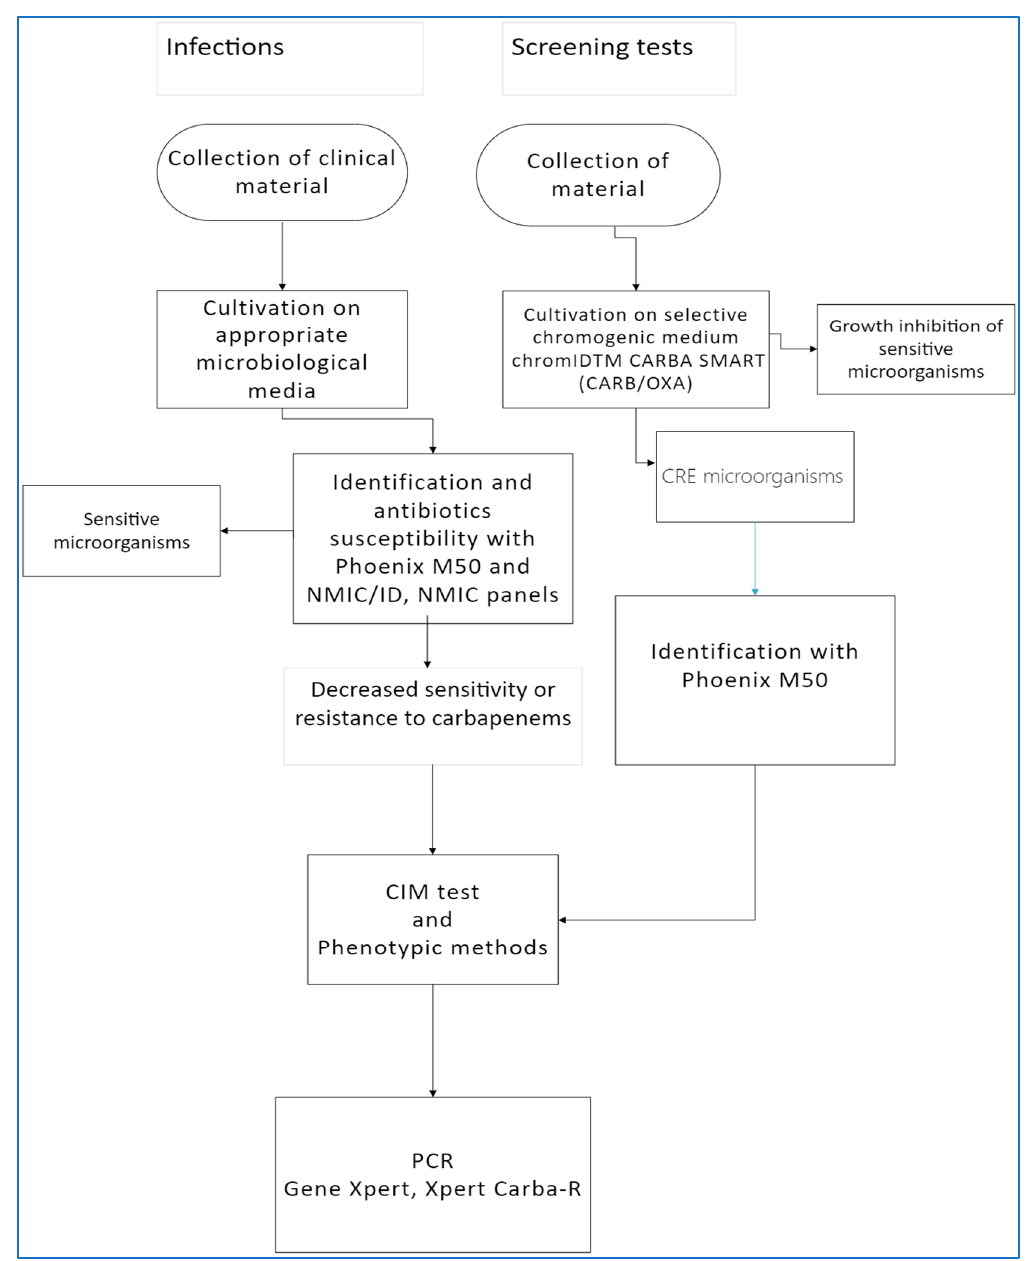
Figure 1. Diagram of CRE diagnostic procedure (CRE—carbapenem-resistant Enterobacteriaceae , CIM—Carbapenem Inactivation Method, and PCR—polymerase chain reaction).